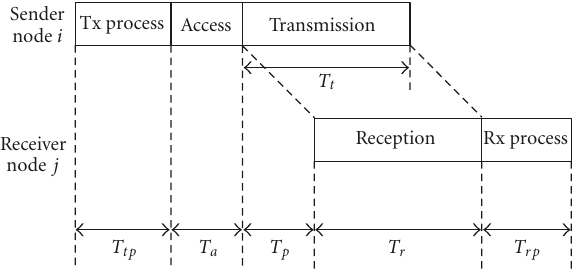
Figure 1: Physical layer-based time delay model.